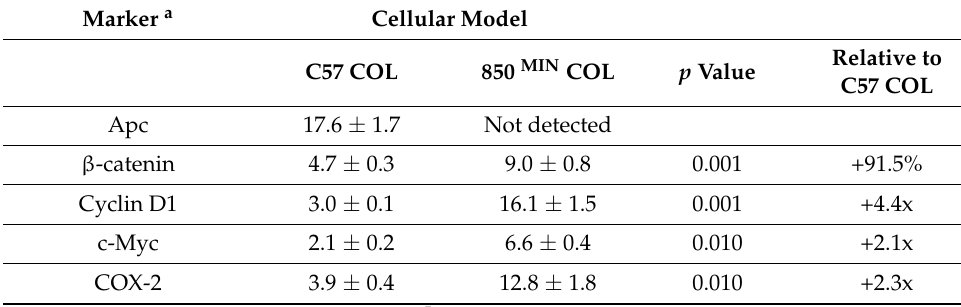
Table 4. Molecular markers in C57 COL and 850 MIN COL